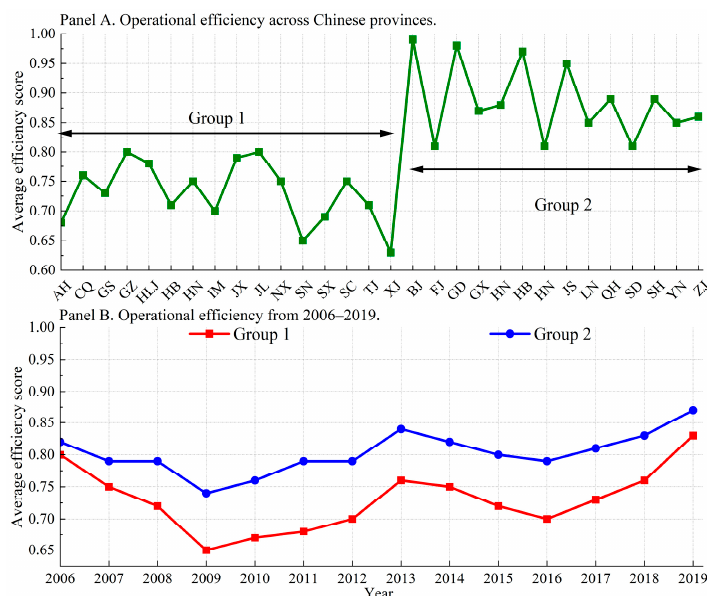
Figure 4. Average OE across Chinese provinces from 2006–2019. Note: AH: Anhui; CQ: Chongqing;